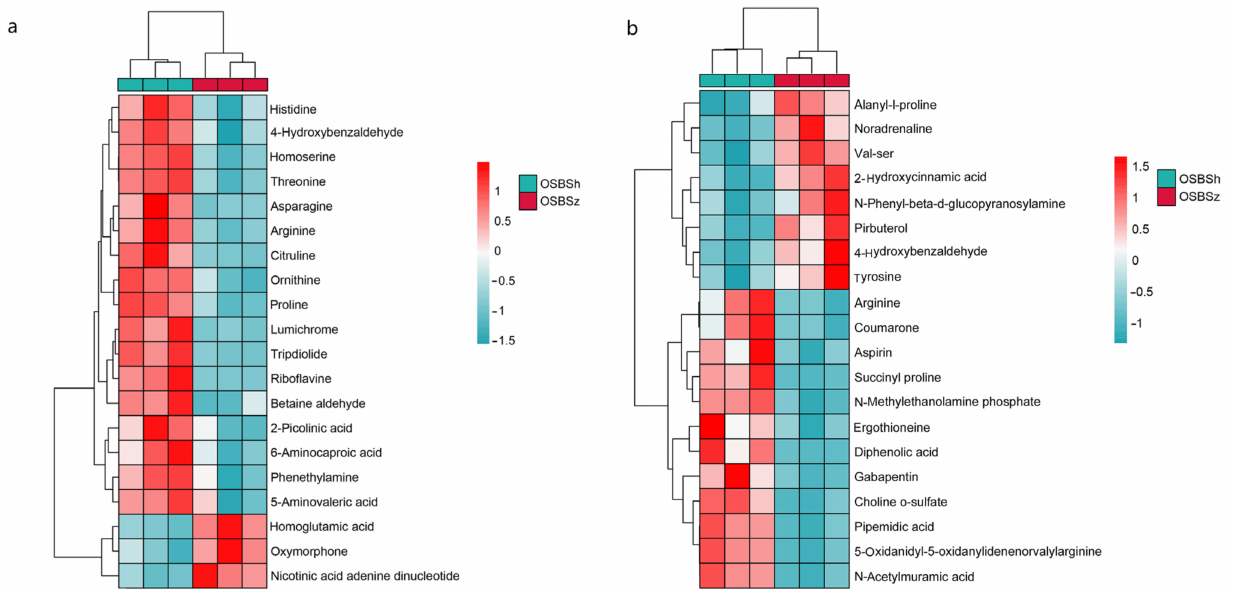
Figure 4. The top 20 differentially expressed metabolites. ( a ) Widely targeted metabolomics. ( b ) Untargeted metabolomics.